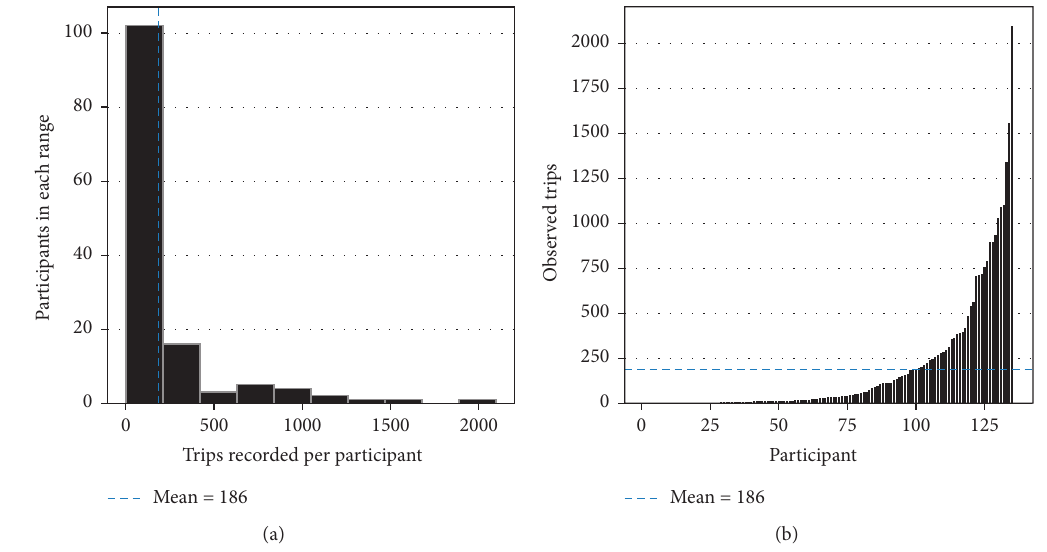
Figure 8: Distribution and share of trips recorded among all participants.